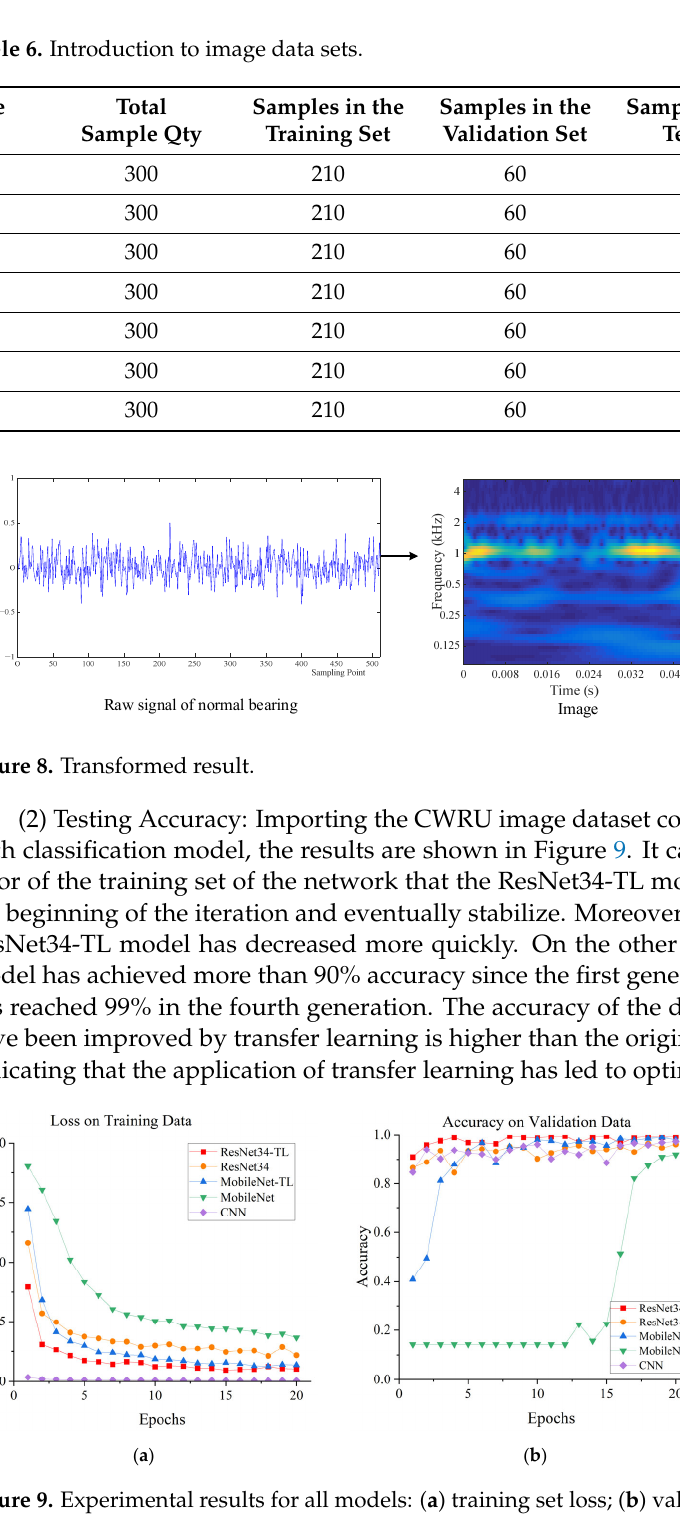
Figure 9. Experimental results for all models: ( a ) training set loss; ( b ) validation set accuracy. The trained models are used for intelligent classification on the test set, and the av ‐ sult. The results are shown in Table 7, the ResNet34 ‐ TL model achieved 99.86% accuracy